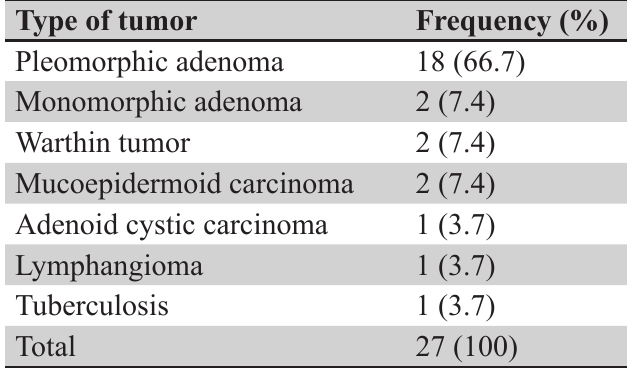
Table 1. Types of parotid tumor (N=27). Type of tumor